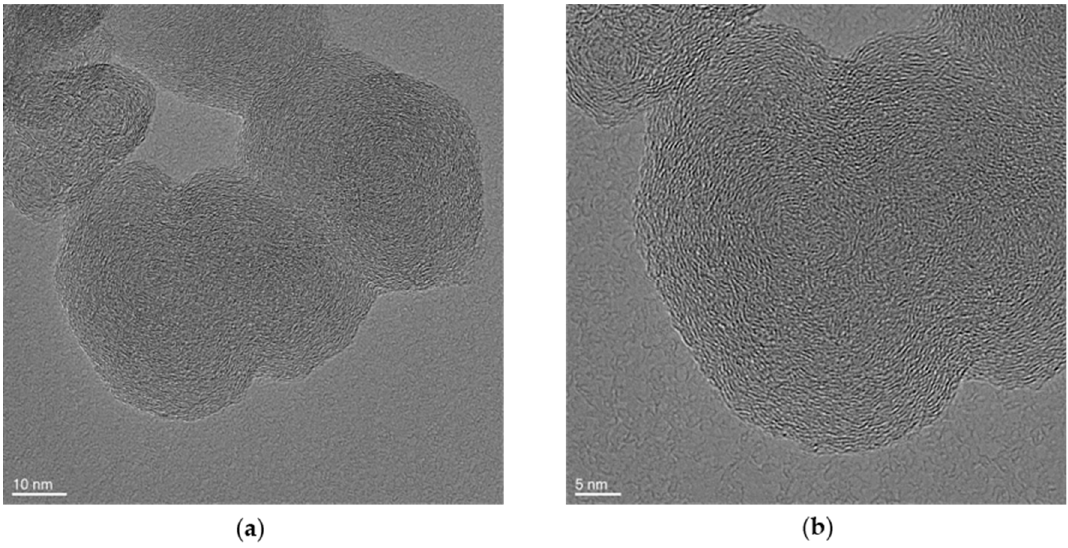
Figure 4. Typical HRTEM images of the GDI PM. ( a ) 10 nm; ( b ) 5 nm.